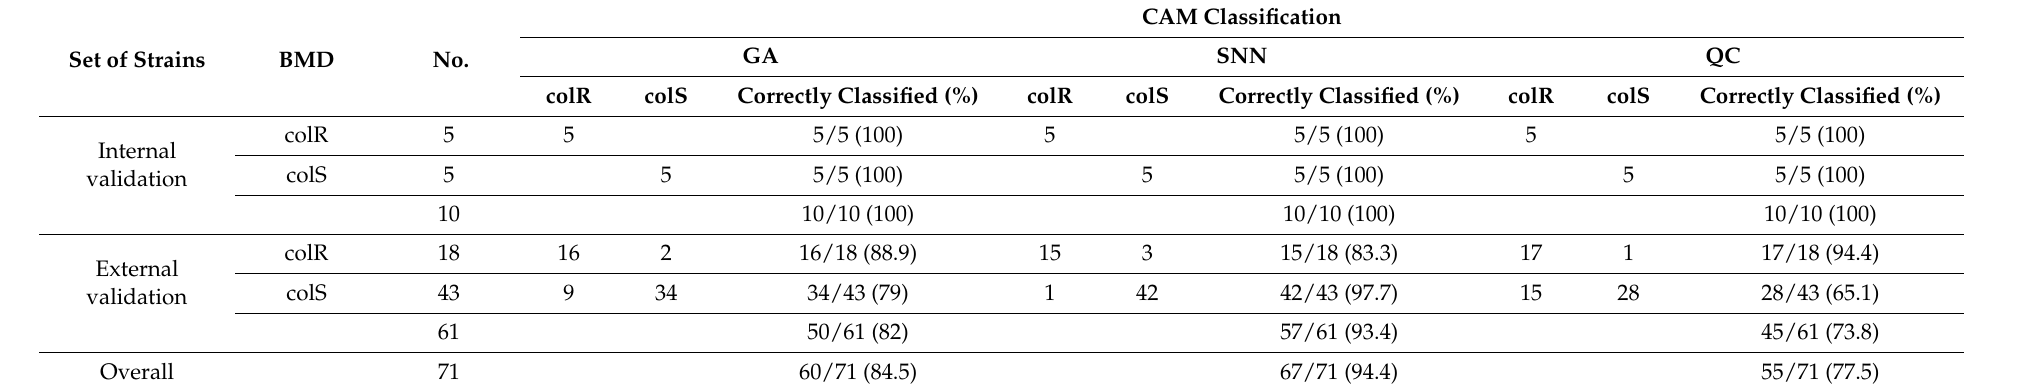
Table 2. Classification of the internal and external validation E. coli strains by the 3 different classifying algorithm models (CAMs). BMD Broth microdilution; GA Genetic Algorithm; SNN Supervised Neural Network; QC Quick Classifier; colR colistin-resistant; colS